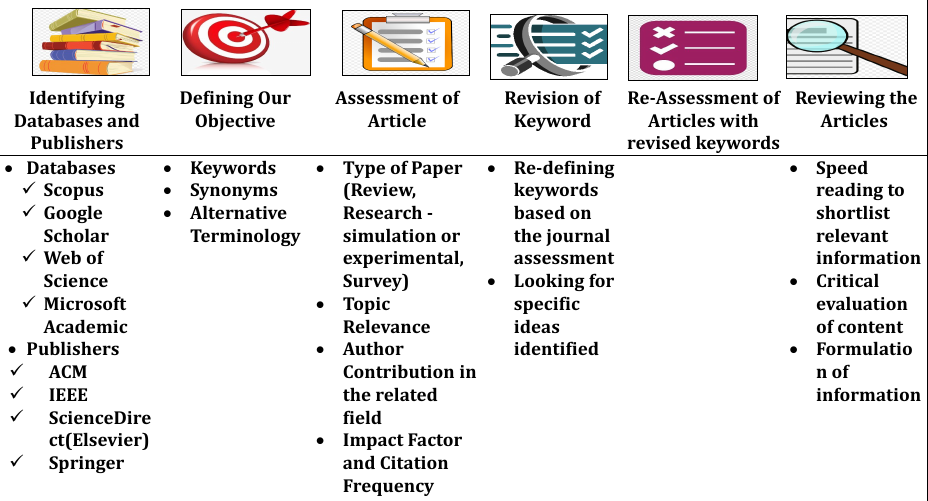
Figure 2. Research